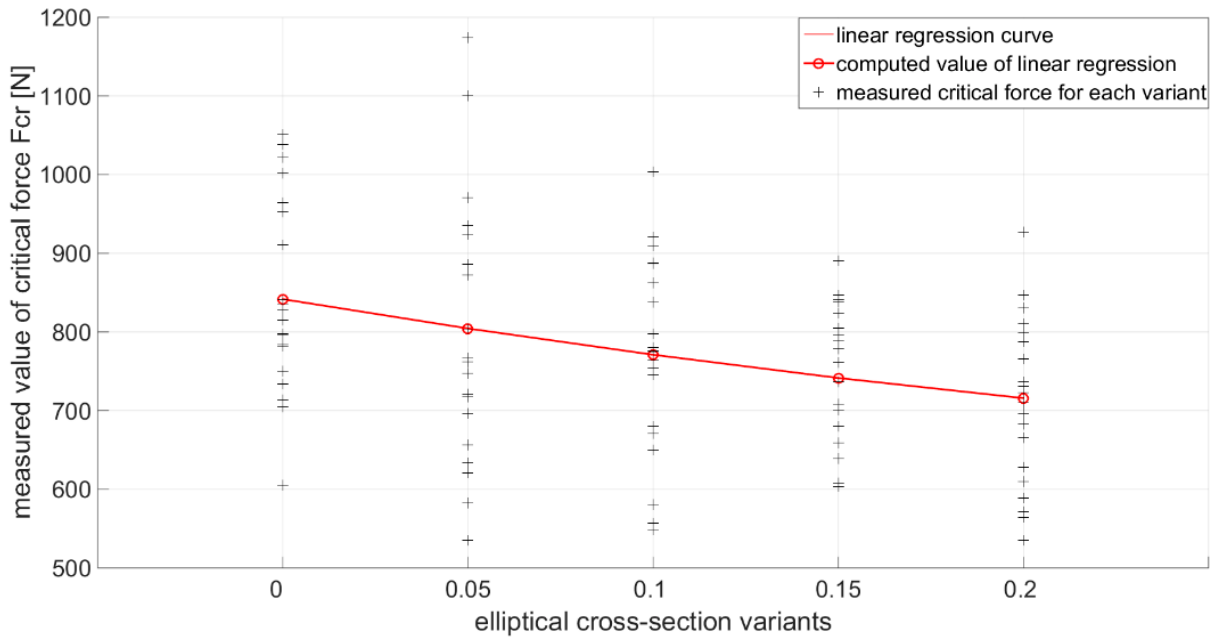
Figure 15. Measurement of critical force F cr for each variant of e and decreasing levels of critical force determined by linear regression. Table 4. Processed data from the measurement of critical force levels F cr . Statistical Parameters